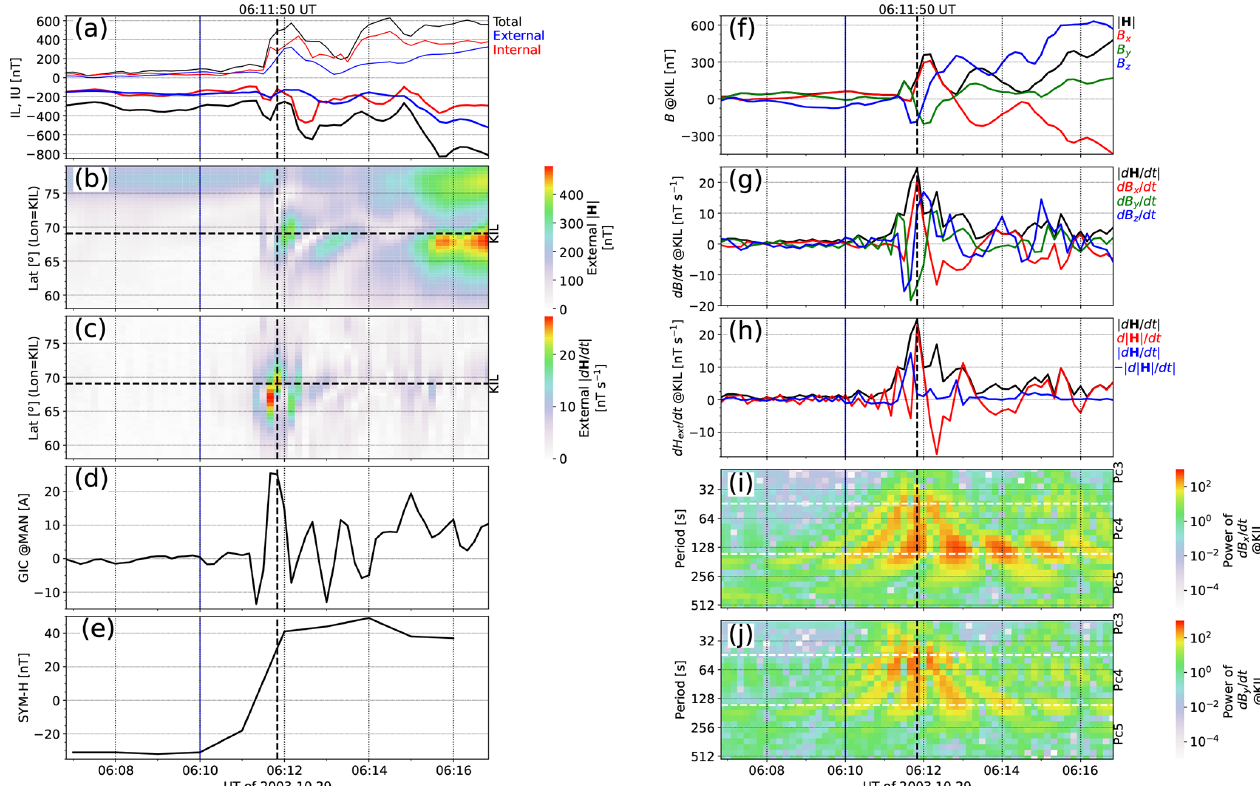
Figure 3. (a) Auroral electrojet indices derived from IMAGE data (Kauristie et al., 1996) ± 5min around the event on 29 October 2003 at 06:11:50UT. The index derived from total (external + internal), external, and internal geographic (cid:49)B x from all available IMAGE stations is drawn with black, blue, and red colors, respectively. The thicker curves show the lower-envelope curve IL index and the thinner curves the upper-envelope curve IU index. (b) Latitude profiles of external ground | (cid:49) H | as a function of UT along the longitude of the KIL station (indicated in Fig. 4 by vertical black lines). (c) Latitude profiles of external 10s | d H / d t | as a function ofUT along the longitude of the KIL station. (d) GICs in the natural gas pipe at MAN (location close to the IMAGE station NUR indicated in Fig. 4). (e) SYM-H index. (f) Geographic external (cid:49)B x , (cid:49)B y , and (cid:49)B z at the KIL station. (g) d B x / d t , d B y / d t , d B z / d t at KIL. (h) Time derivative of the external horizontal magnetic field vector ( | d H / d t | ), time derivative of the amplitude of the horizontal ground magnetic field vector (d | H | / d t ), and the difference | d H / d t |−| d | H | / d t | , which represents the contribution of the change in vector direction to | d H / d t | at KIL. (i–j) Wavelet transform of d B x / d t and d B y / d t at KIL. The period ranges of the ultra-low-frequency (ULF) pulsation classes Pc3 (10–45s), Pc4 (45– 150s), and Pc5 (150–600s) (Jacobs et al., 1964) are shown with the horizontal dashed white lines. The vertical blue line indicates a SC at 06:10:00UT, and the vertical dashed black line indicates the time of the extreme external | d H / d t | observed at